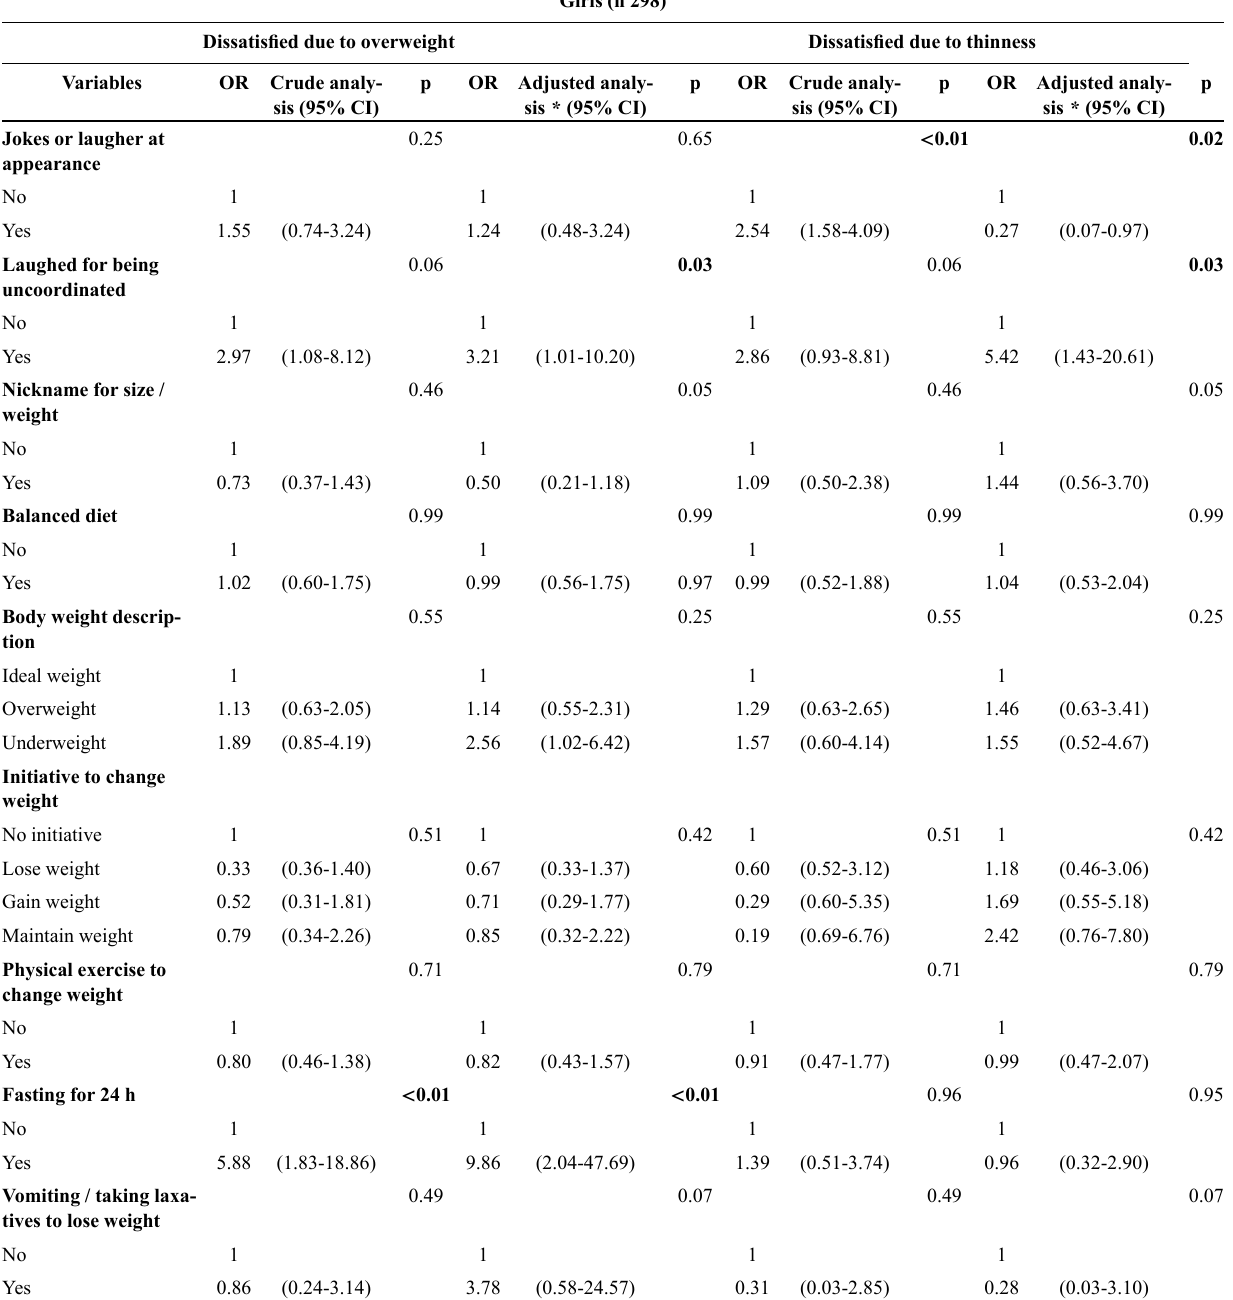
Table 3 - Crude and adjusted multinomial logistic regression analysis between body image and behaviors and attitudes for weight control in girls' adoles- cents from the municipality of Criciúma, Santa Catarina,